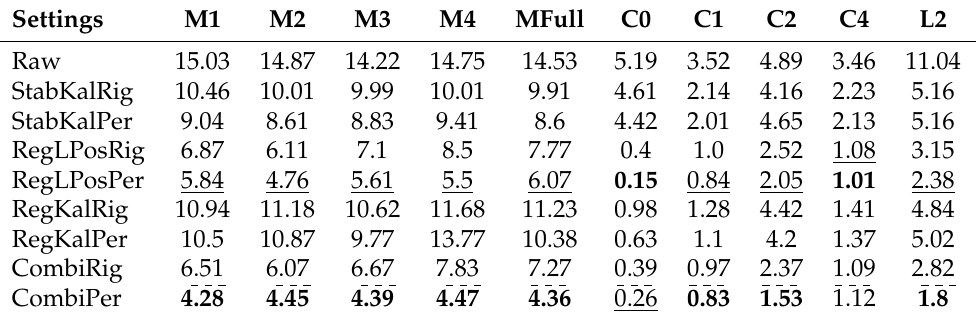
Table 3. Ratio of segmented foreground pixels ( fgr ) within the database as a percentage. First rank ; Second rank; Third rank. Lower values suggest that less background motion was wrongly considered as foreground